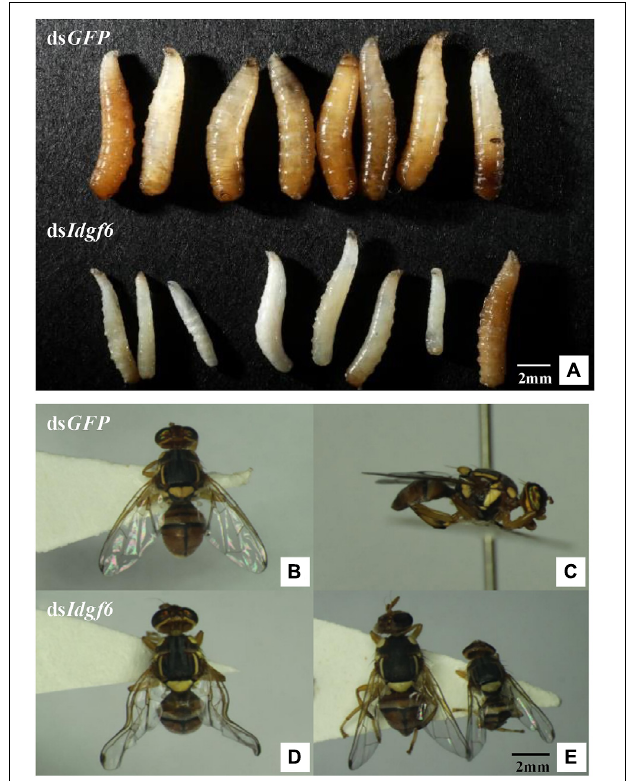
FIGURE 5 | B. correcta larval and adult malformed individuals after silencing. (A) Malformed phenotype of larvae after feeding ds GFP and ds Idgf6 . (B) Front view of the phenotype of adults after feeding ds GFP . (C) Side view of the phenotype of adults after feeding ds GFP . (D) First type of malformed phenotype observed in adults after feeding ds Idgf6 , which resulted in partly extended wings. (E) Second type of malformed phenotype of adults after feeding ds Idgf6, which led to smaller fruit